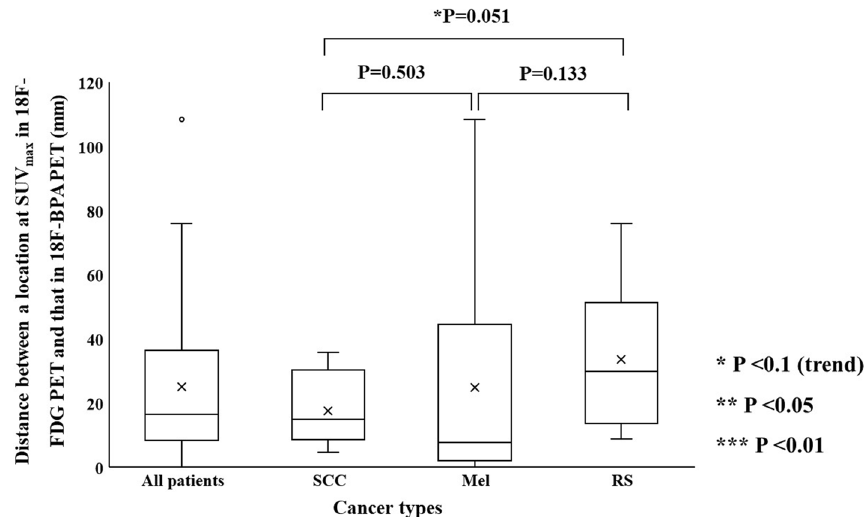
Fig. 7 The distances between locations at SUV max between 18 F-FDG and 18 F-BPA PET for all patients, squamous cell carcinoma, melanoma, and rhabdomyosarcoma